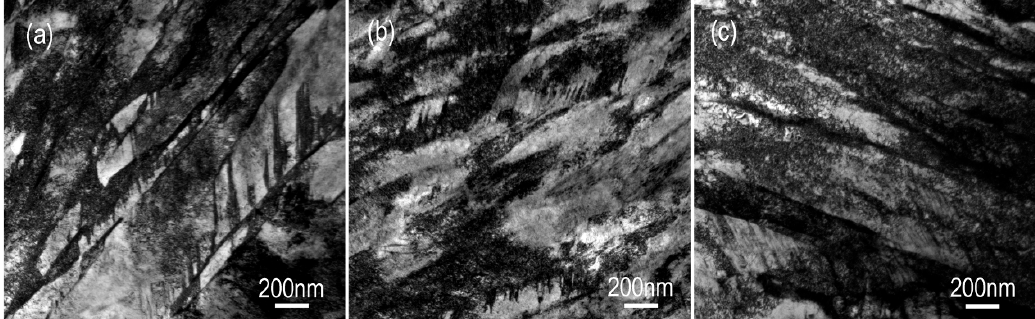
Figure 9. BF images of the deformed Q-P-T specimens at various temperatures: ( a ) 25 °C; ( b ) 200 °C and ( c ) 350 °C.